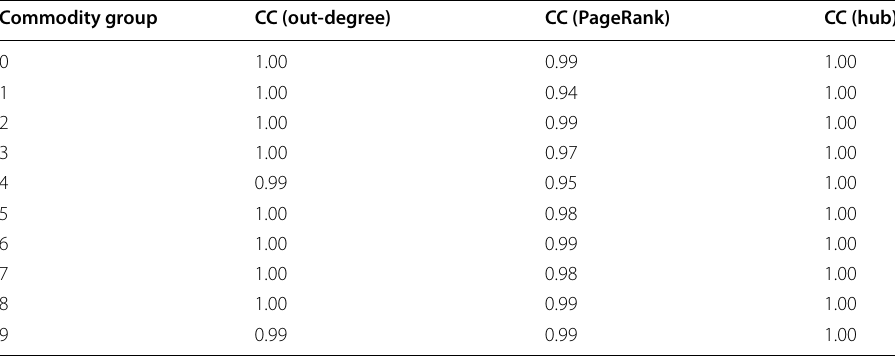
Table 2 Correlation coefficients between the ranks of the 154 countries in the 154-country network and the same countries in the 234-country network, based on centrality measures in 10 commodity groups in the export